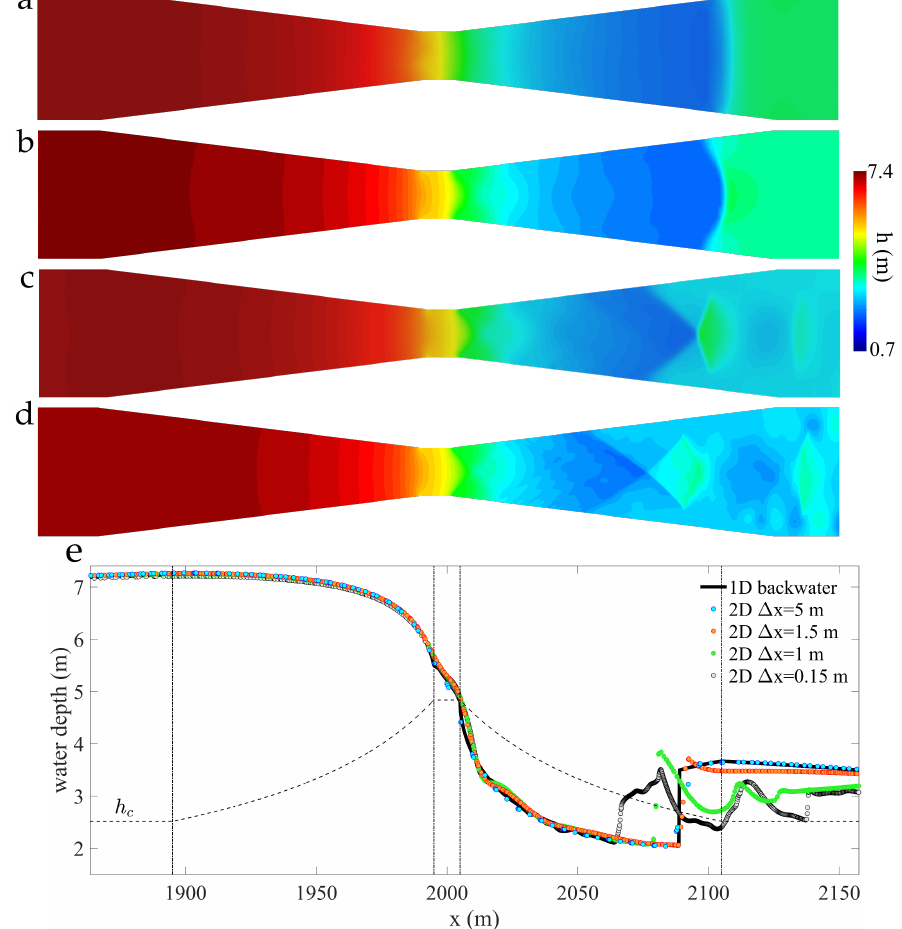
Figure 16. Impact of grid refinement on 2D shallow-water simulations of transcritical flow. We show maps of water depth computed using different grid sizes in the contraction region, ∆ x = 5,1.5,1,0.15 m (panels a – d respectively). The length of the expansion zone is L e = 100 m and the distance to the outlet is L d = 250 m. The coarse grid solution is quasi-1D, showing an excellent match with the water profile computed using the classical 1D theory (panel e ). As the grid is refined, and the simulations capture the complex 2D flow features, the 1D and 2D predictions deviate significantly. In particular, the sharp hydraulic jump of the 1D theory is replaced by an intricate sequence of oblique standing waves (panel d